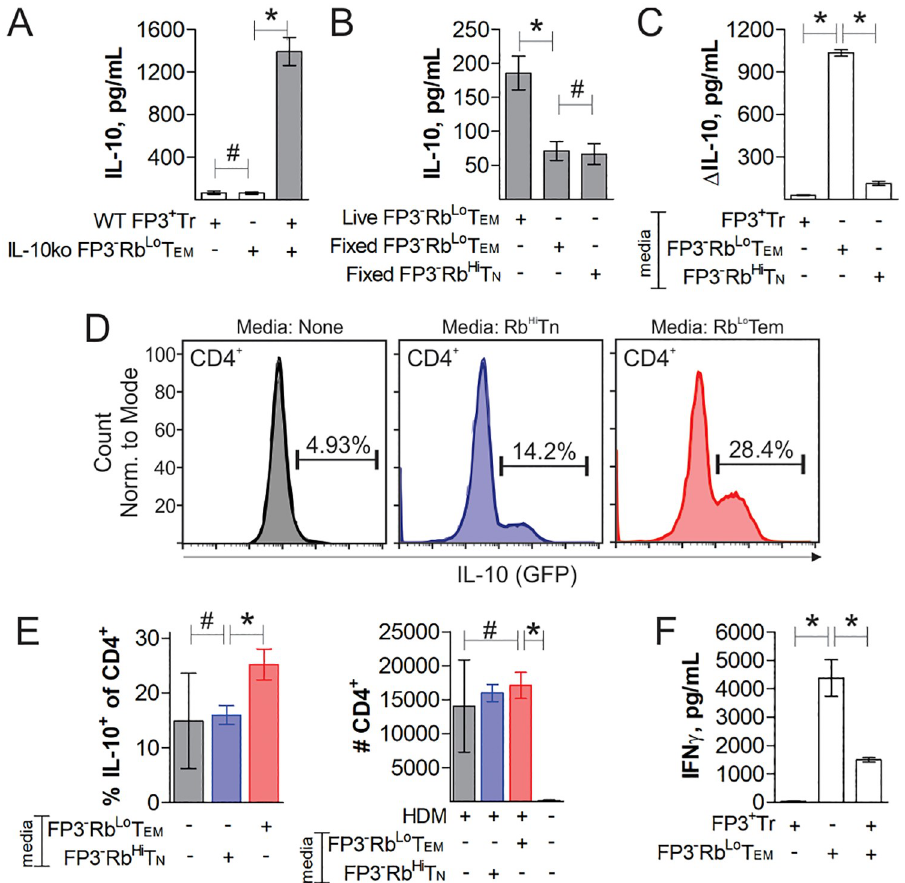
Fig 3. T cell synergy is mediated by a soluble factor. Cells were flow sorted, stimulated with anti-CD3 ε antibody for 3 days, and treated as indicated. ELISA measurements of IL-10 concentration in culture supernatant from FoxP3 + Tregs co-cultured with IL-10-knockout Rb Lo Tem (A), fixed Rb Lo Tem or Rb Hi Tn cells (B) or the change in IL-10 in the supernatant from cultured FoxP3 + Tregs supplemented with conditioned media from Rb Lo Tem, Rb Hi Tn or FoxP3 + Tregs stimulated previously for 3 days as before (C). Conditioned media from activated Rb Lo Tem or Rb Hi Tn cells were administered to HDM-challenged IL-10-GFP reporter mice intranasally and compared to resting and HDM- challenged mice without conditioned media. Mice were sacrificed and the BALf was analyzed by flow cytometry, showing percent IL-10 + among CD4 + cells in representative histograms (D) as well as replicates and the total CD4 + cell counts (E). ELISA measurements of IFN γ concentration in culture supernatants from FoxP3 + Tregs, WT Rb Lo Tem, or both cells in co-culture with anti-CD3 ε stimulation for 4 days (F). � = p < 0.05; # = p > 0.05. P value calculated from Student’s T-Test. Error bars show mean with SEM. For A-C, n = 3 to 6 experiments. For E-F, n = 3